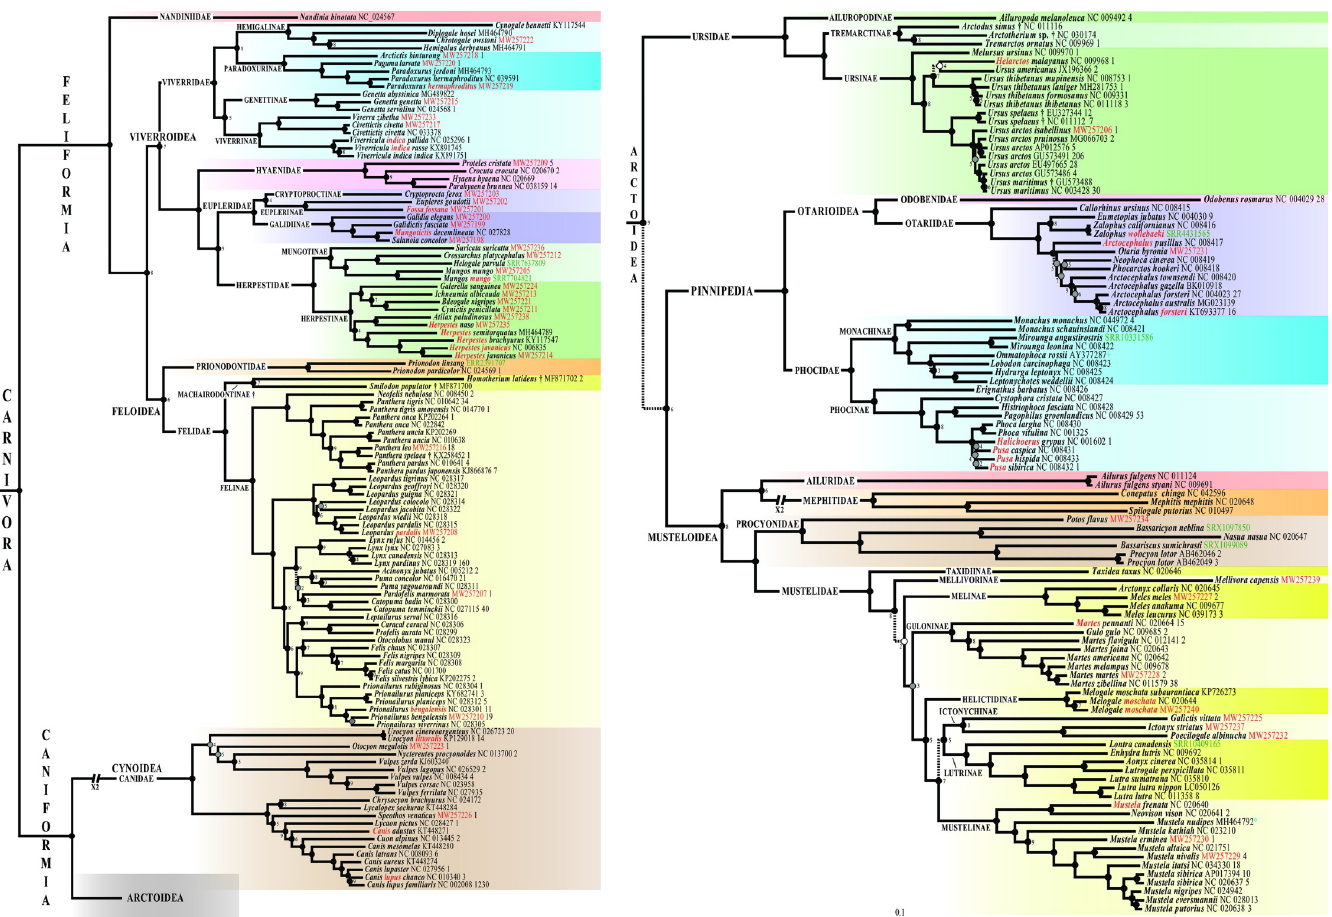
Fig 2. Phylogeny of Carnivora based on mitogenomes. The Bayesian tree was reconstructed using the mtDNA dataset (220 taxa and 14,892 bp) and GTR+I+G model. The two outgroup species are not shown. Species names follow the classification of the IUCN [1]; the taxa written in red highlight the taxonomic issues discussed in the main text. The accession numbers of the 42 mitogenomes of Carnivora specially sequenced for this study are indicated in red. The eight mitogenomes here assembled from SRA data are shown in green. The blue circle associated to Mustela nudipes MH464792 indicates that the mitogenome was originally misassigned to Viverra tangalunga . Fossil species are followed by the symbol “†”. For each terminal taxon, the number of similar mitogenome(s) found in GenBank (pairwise distance < 1%) is indicated after the accession number. Dash branches indicate nodes supported by posterior probability (PP) < 0.95. Black circles indicate nodes that are also monophyletic in the two following trees: SuperTRI bootstrap 50% majority-rule consensus tree; and Bayesian tree obtained from the analysis of the mtDNA-Tv dataset and JC69+I+G model. Grey circles show nodes that are not found to be monophyletic with one of the two methods detailed above. White circles indicate nodes that are not monophyletic in both mtDNA-Tv and SuperTRI bootstrap consensus trees. No information was provided for the nodes highly supported by the SuperTRI analyses, i.e. which were found monophyletic in all the 10 Bayesian trees reconstructed from the 10 half-overlapping sub-datasets of the mtDNA dataset. For nodes less supported by the SuperTRI analyses, the number of Bayesian trees ( < 10) showing the nodes is indicated.